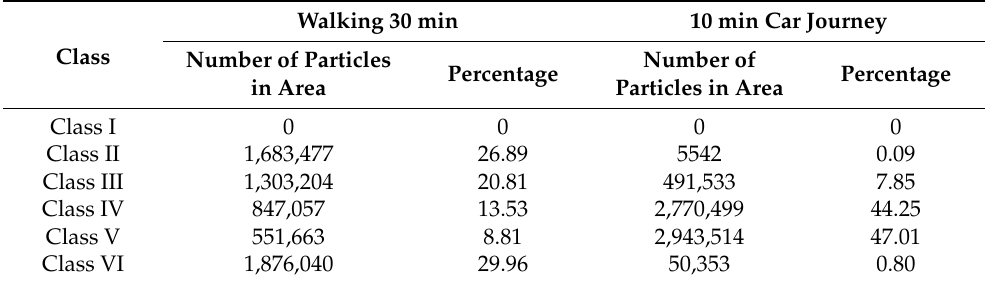
Table 7. Equity level statistics for overall area with walking 30 min and driving 10 min by car.